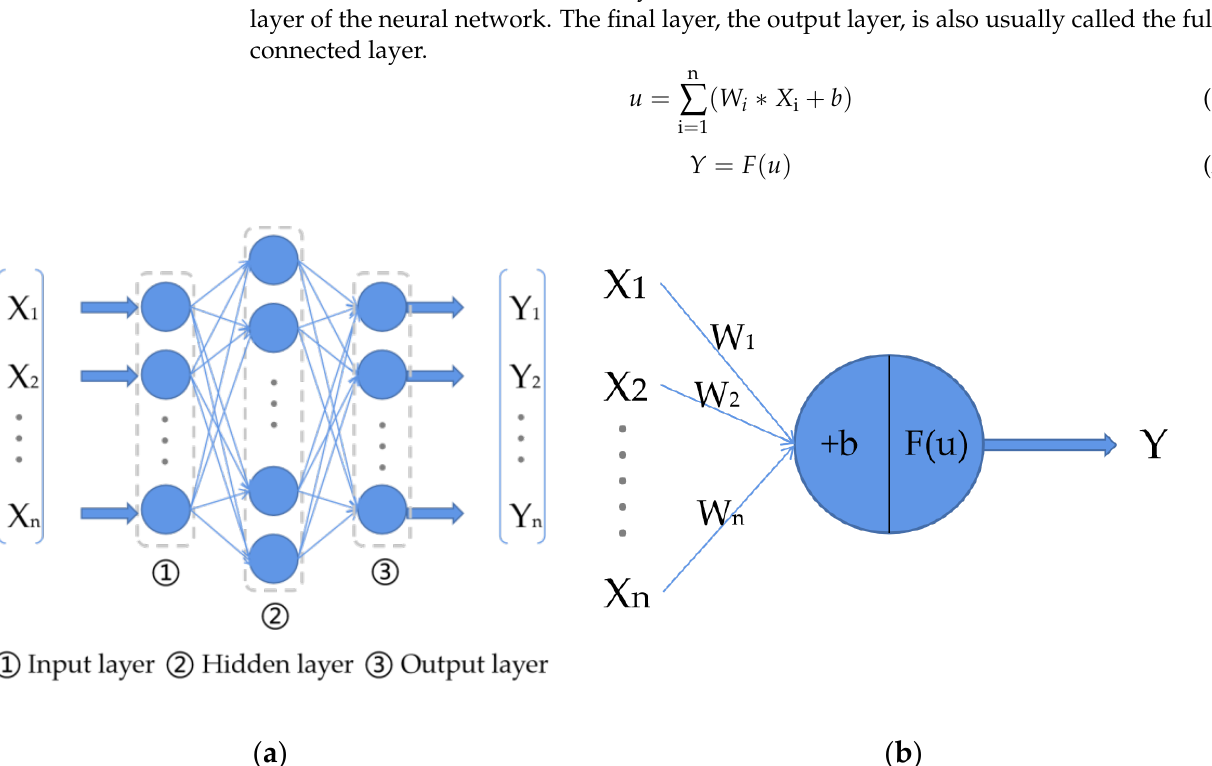
Figure 8. The structure of a classical neural network and a neuron: ( a ) classical neural network with three layers; ( b ) the structure of a neuron in a neural network.